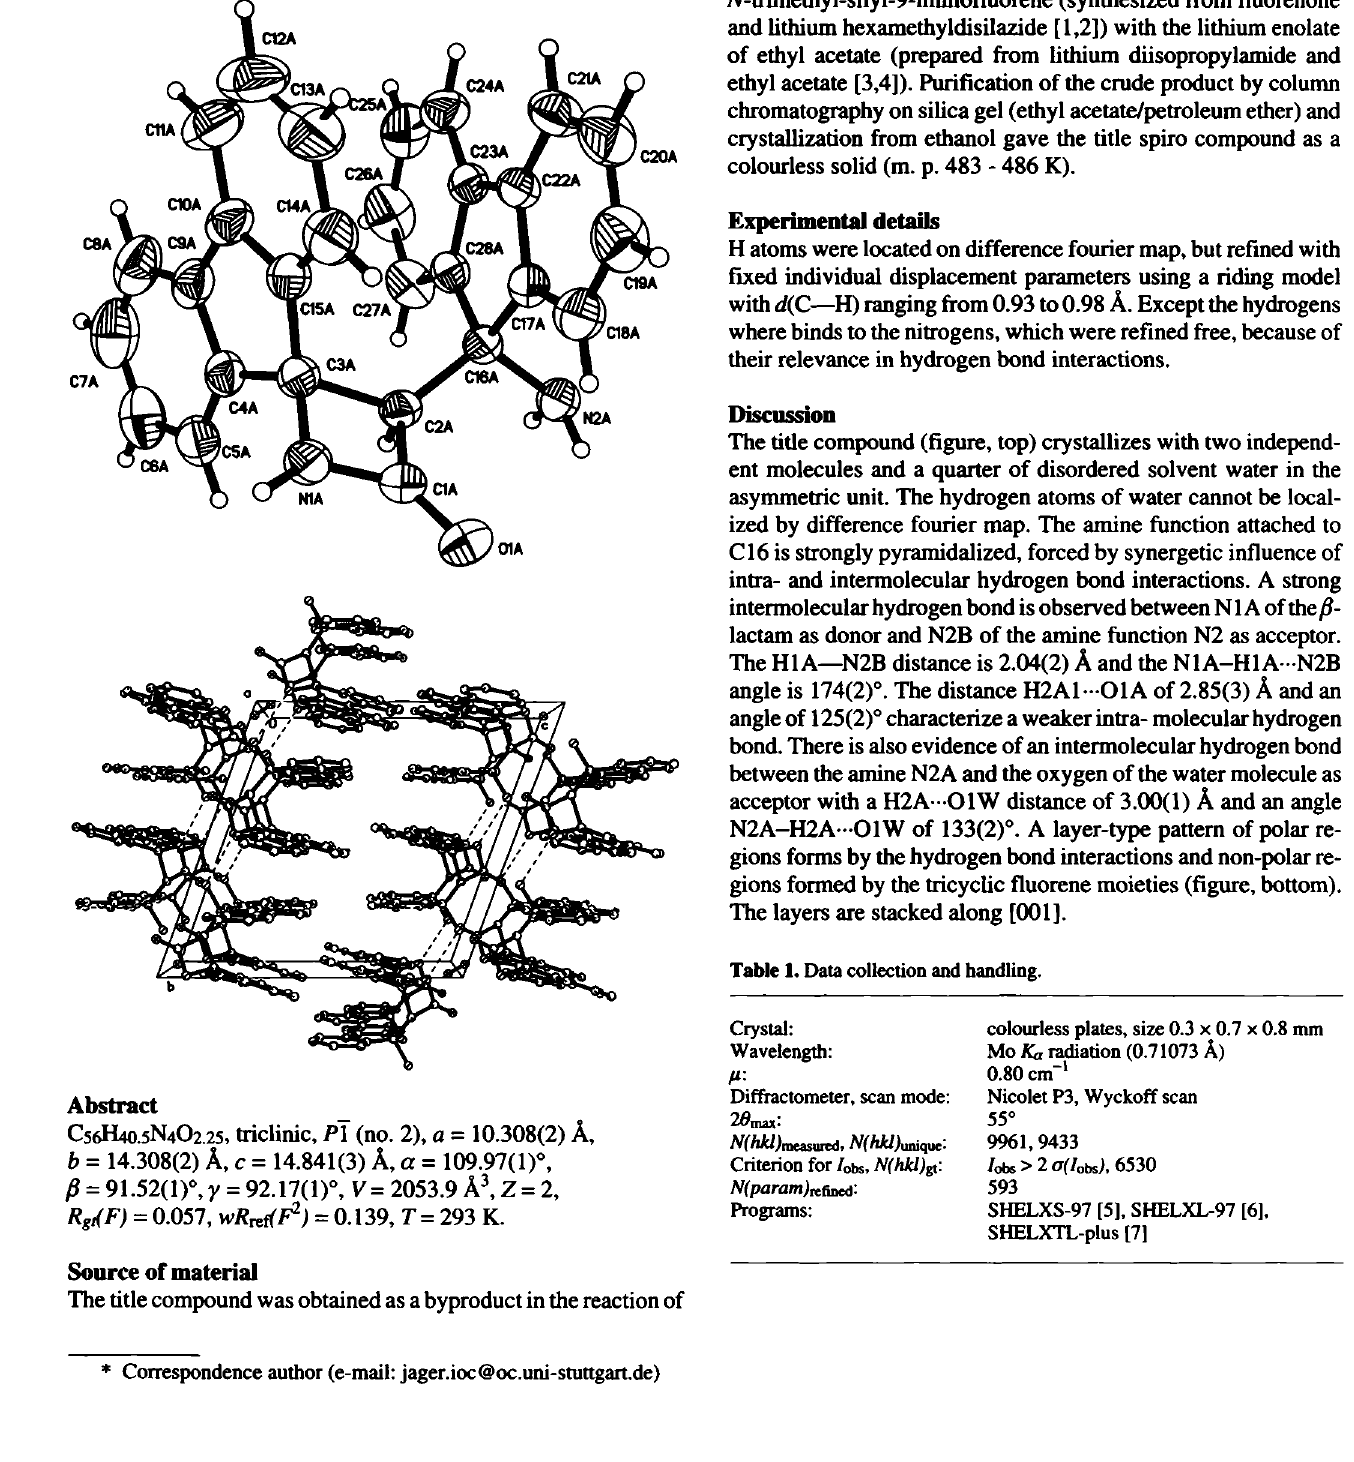
Table 1. Data collection and